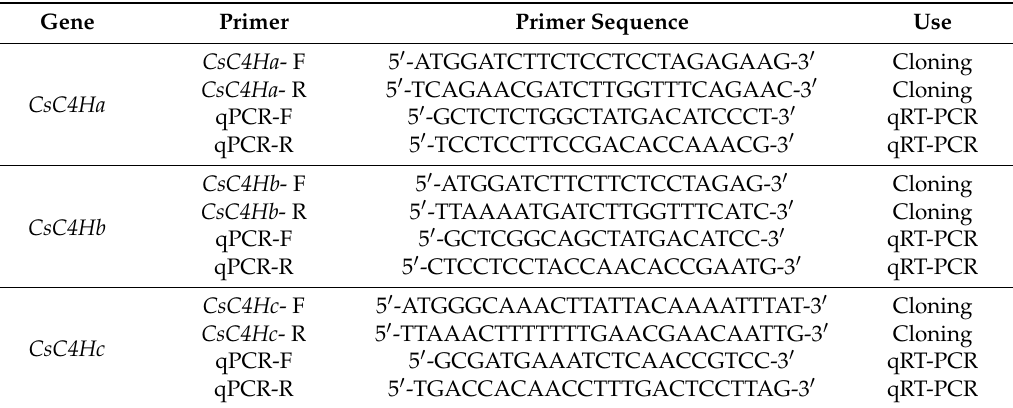
Table 1. Primers used in the